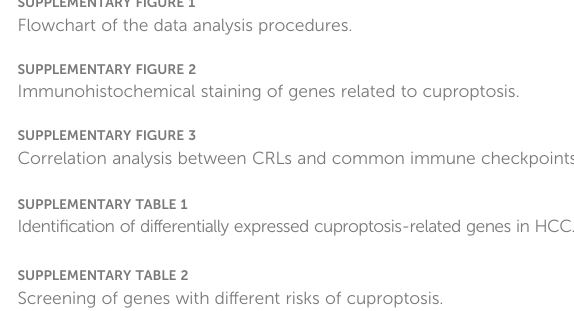
SUPPLEMENTARY FIGURE 1 Flowchart of the data analysis procedures. SUPPLEMENTARY FIGURE 2 Immunohistochemical staining of genes related to cuproptosis. SUPPLEMENTARY FIGURE 3 Correlation analysis between CRLs and common immune checkpoints.